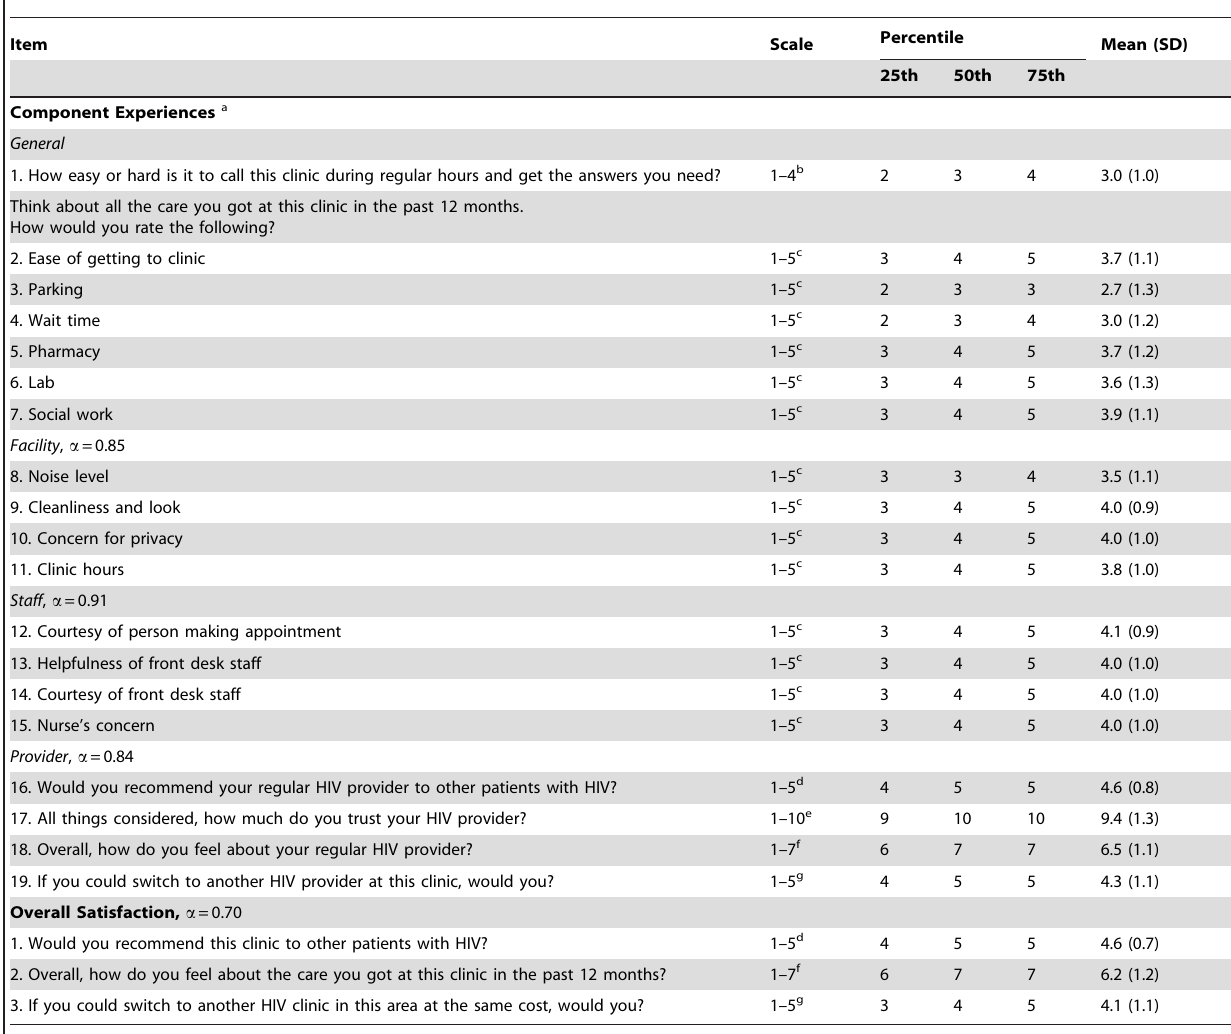
Table 1. Distribution of item responses and reliability of multi-item